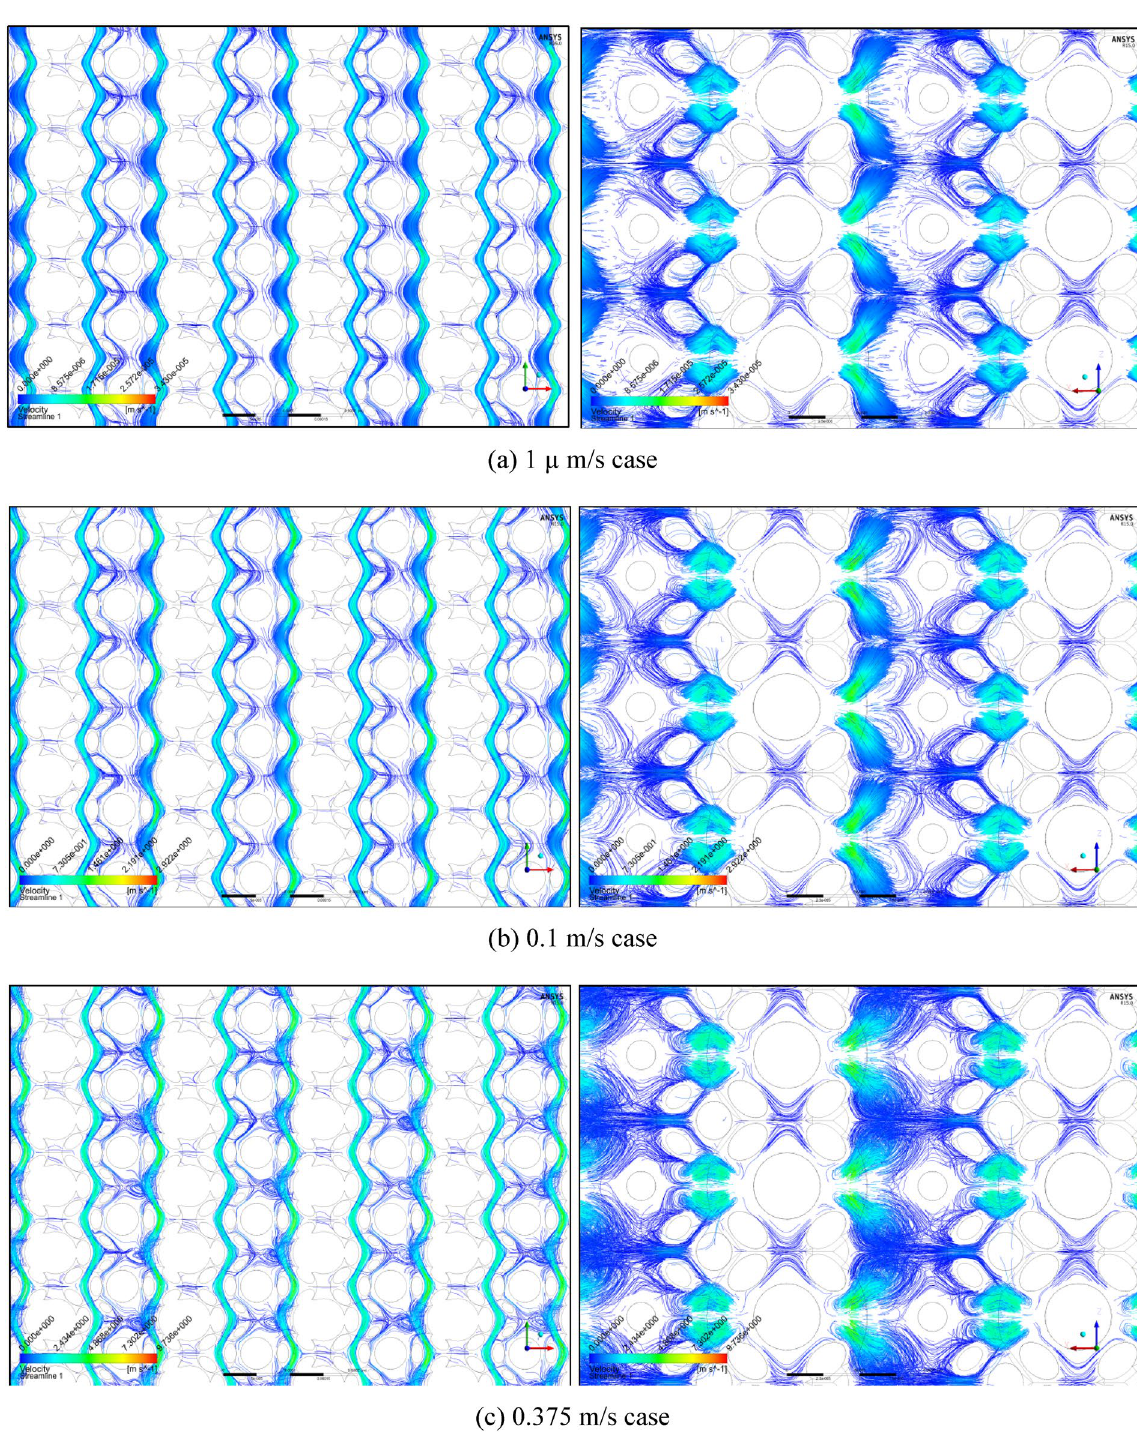
Figure 4. Streamline comparison of (C) multi-size base model in the three Y-directional flow conditions focusing on the centre parts in the X–Y (left) and X–Z (right)